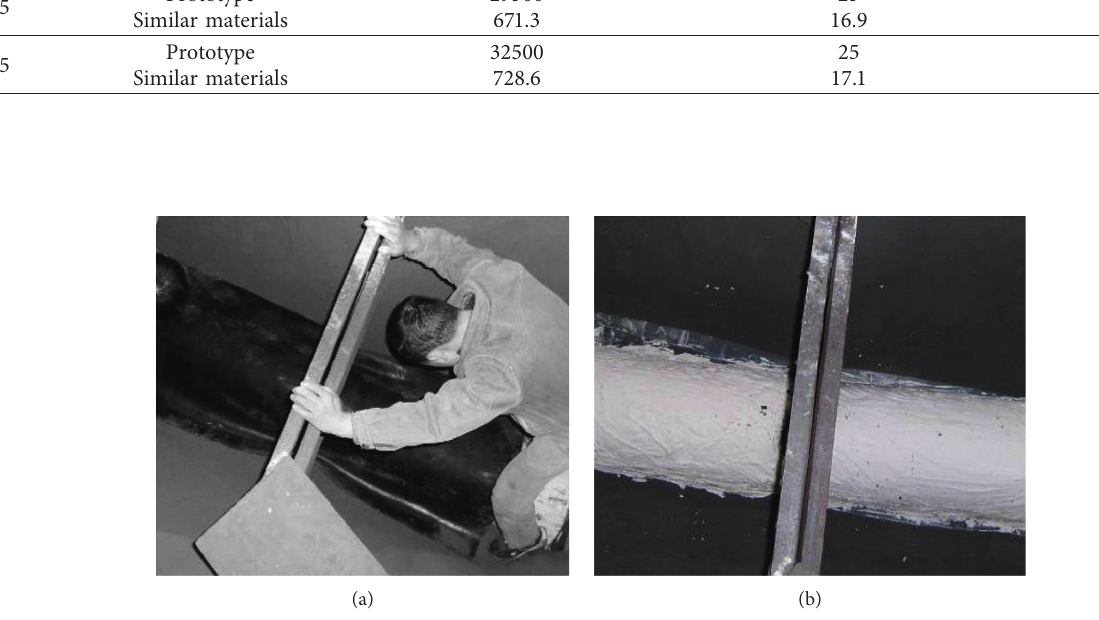
Figure 4: Test similar material. (a) The reducing dislocation layer. (b) Flashing and primary